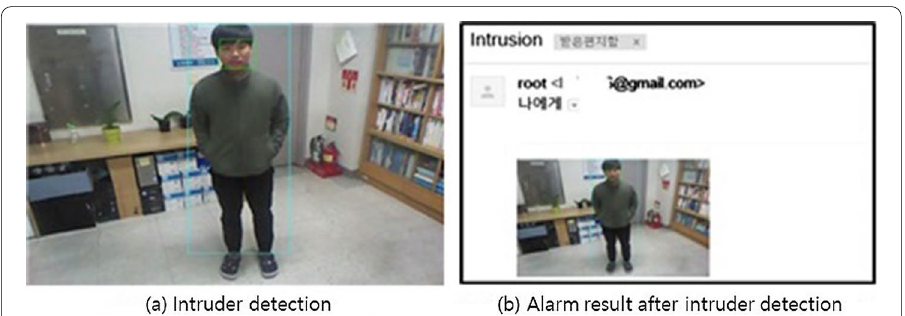
Fig. 17 Notify in case of an abnormal situation